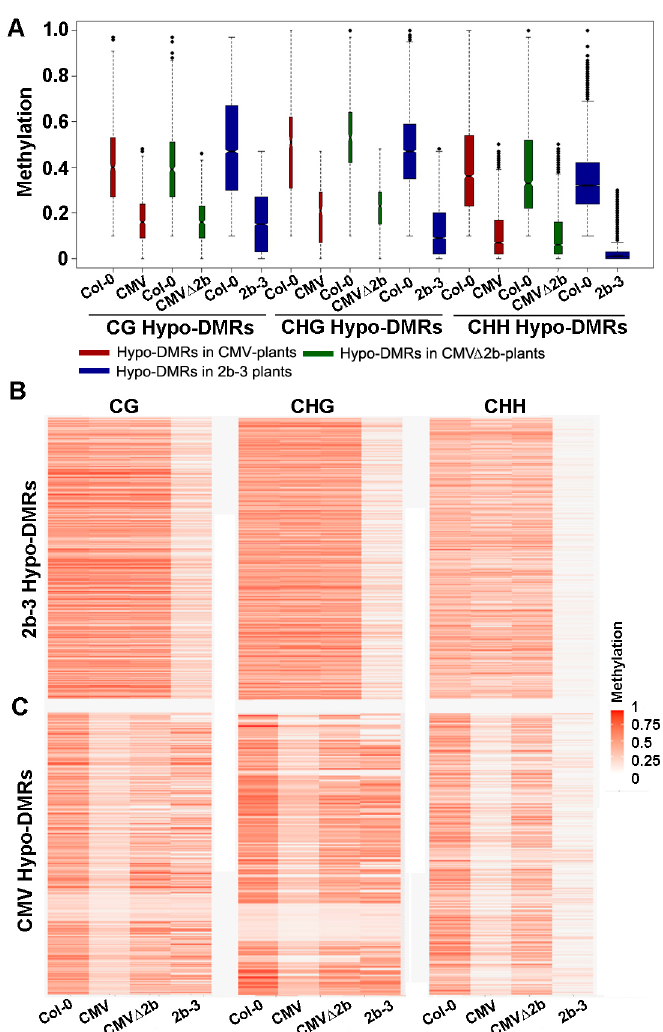
Figure 2. The methylation level of Hypo-DMRs in CMV-, CMV ∆ 2b- and 2b-3 plants. ( A ) Boxplots of the methylation level of each Hypo-DMR in CG, CHG, and CHH contexts in CMV-, CMV ∆ 2b- and 2b-3 plants. The width of the column indicates the quantity of Hypo-DMRs. ( B , C ) Heat map of the methylation level within each Hypo-DMR identified in 2b-3 plants ( B ) and CMV-plants ( C ). The degree of methylation to each Hypo-DMR coincided with the degree in red for each heat map.